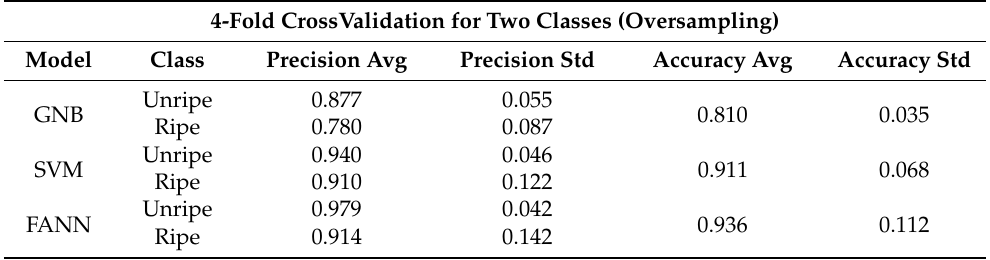
Table 9. Performance of three ML models for two-class classification using oversampling data. 4-Fold CrossValidation for Two Classes (Oversampling)